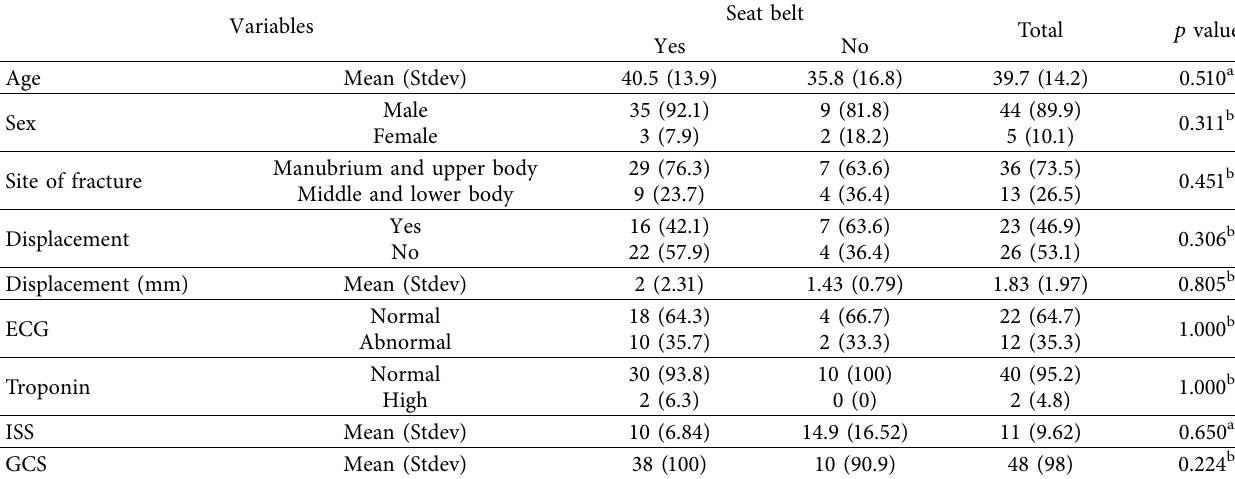
Table 2: Comparison between belted and unbelted MVC patients with sternal fracture in terms of diferent variables.